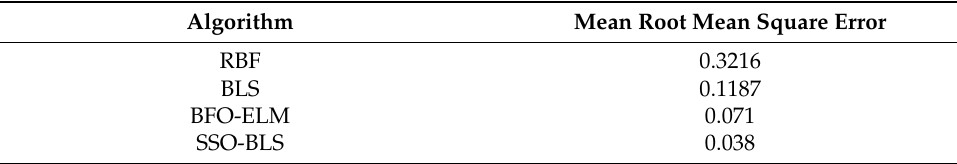
Table 2. Average fitting error of different